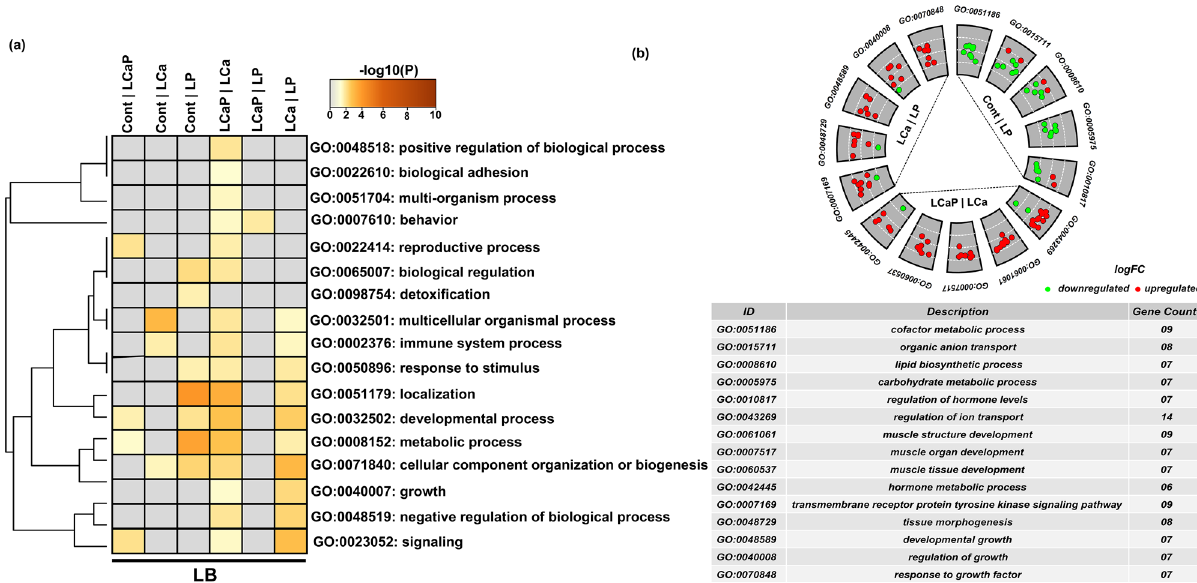
Figure 6. Gene ontology enrichment analysis of differentially expressed (DE) known miRNAs and their DE target genes from pairwise comparisons between diet groups within LB strain. ( a ) Enrichment analysis of DE miRNAs and their target genes from different dietary comparisons was performed in Metascape. All statistically enriched biological processes with accumulative hypergeometric P values and enrichment score were identified. Significant biological terms were then hierarchically clustered into a tree based on Kappa-statistical similarities among their genes. Kappa score 0.3 was applied as threshold to cast the tree into biological term clusters. The heatmap cells are colored by their P values. Grey color indicates lack of enrichment and brown color indicates significant enrichment for that term in corresponding group gene list. ( b ) Go circular plot was generated by using Goplot (version.1.0.2) (https:// CRAN.R- proje ct. org/ packa ge= GOplot) within R programming environment (https:// www.R- proje ct. org/). Only the dietary comparison groups, which indicated the significant enrichment, were selected. Top five biological processes were selected from these enriched groups on the basis of number of genes involved in a biological process. White dotted line indicates the partition of logFC from low to high